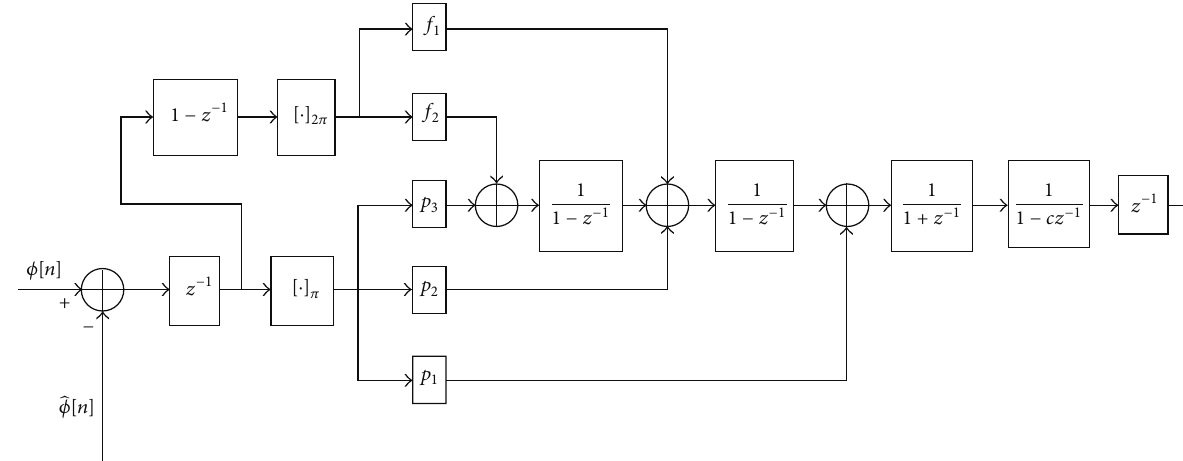
Figure 3: The structure of the optimum PLL for tracking Doppler